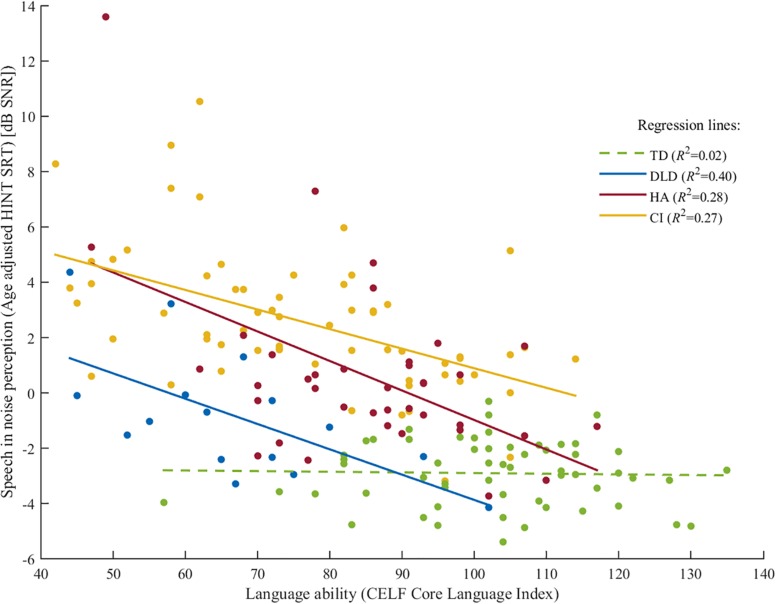
Scatterplot of HINT SRTs versus CELF-4 Core Language Index for children with CI (yellow), HA (red), DLD (blue) and TD (green). The solid lines are linear regression lines for groups CI, HA, and DLD (p ≤ 0.005). The green dashed line is a non-significant linear regression line (p = 0.29) for the TD group.